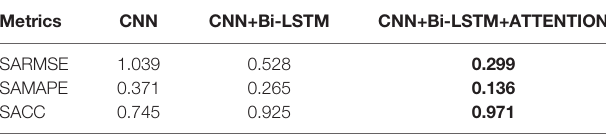
TABLE 1 | One-hour performance